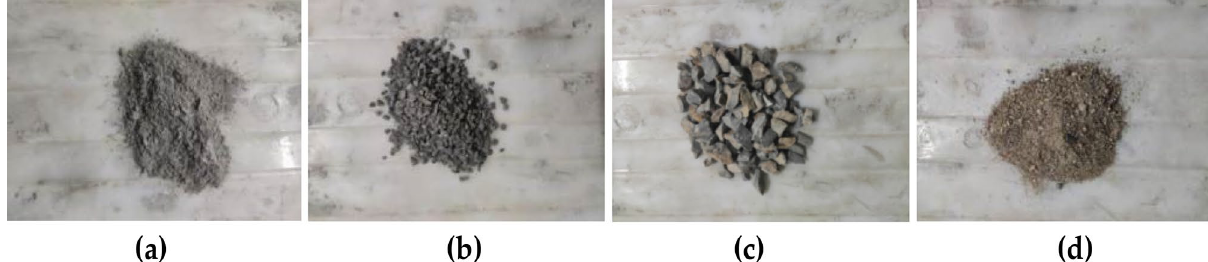
Figure 1. Concrete mix design materials: (a) cement; (b) 5–10 mm aggregate; (c) 10–19 mm aggregate; (d) river sand.